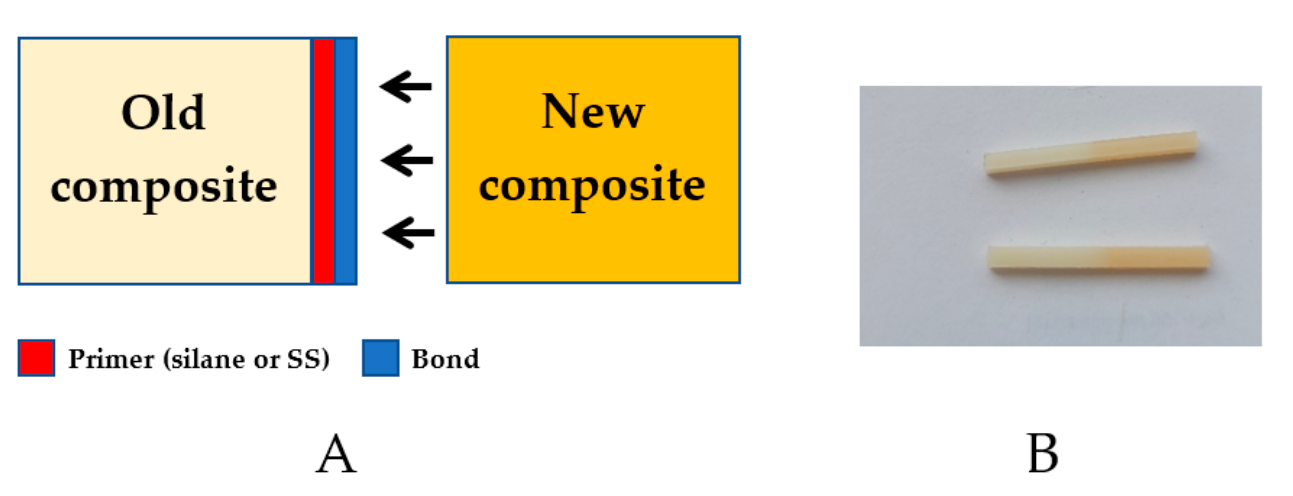
Table 1. Samples prepared for tests.